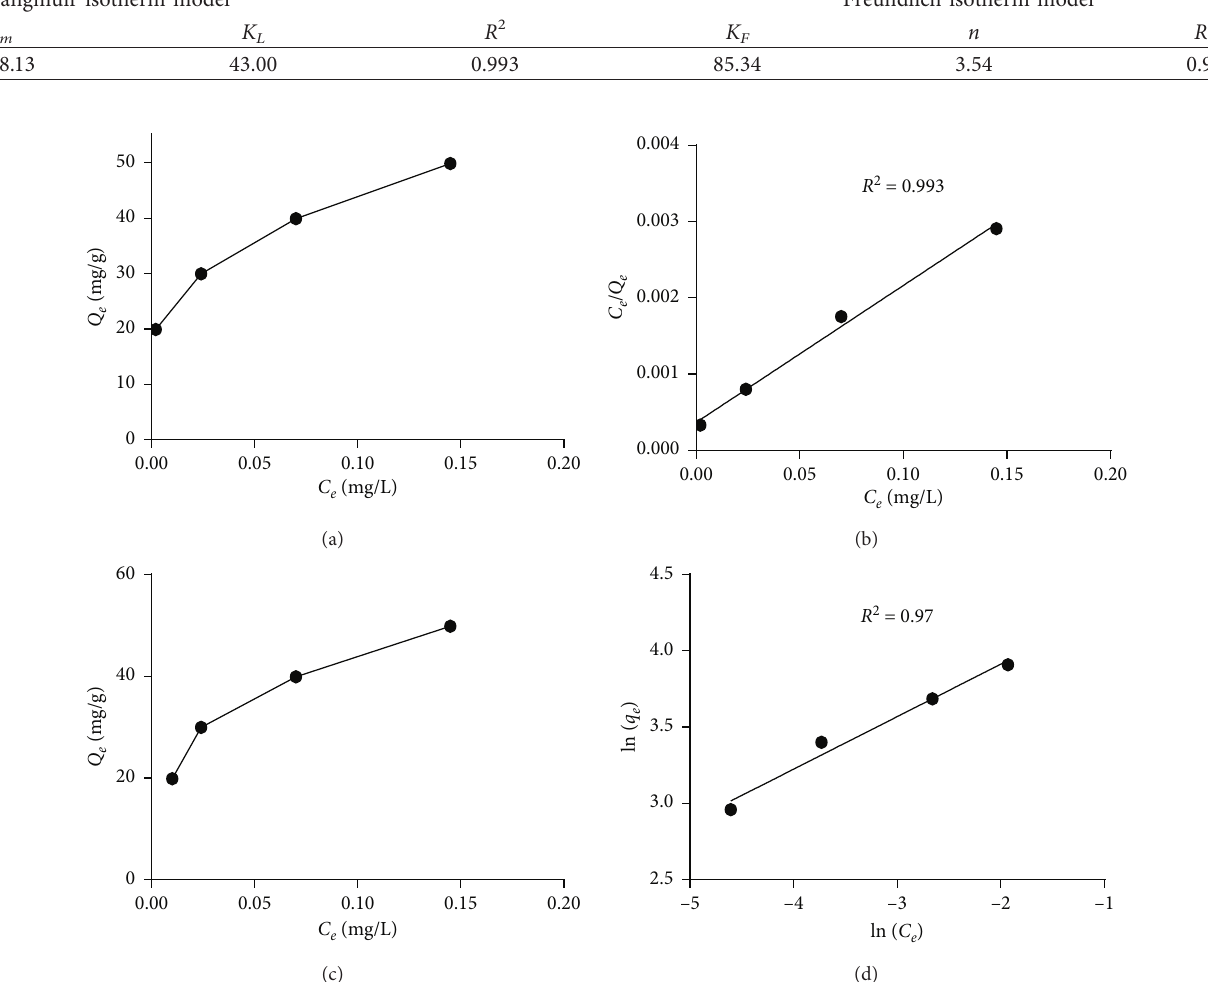
Table 4: Isotherm constants for BG dye adsorption on almond shell powder (ASP). Langmuir isotherm model